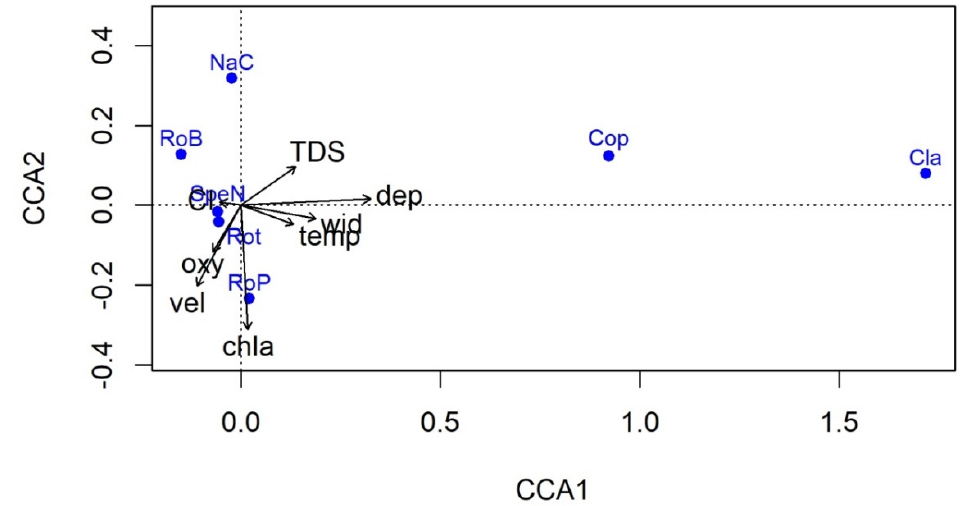
Figure 6. Zooplankton taxa abundance and species number of total zooplankton among environmental factors in the Bukówka stream. Canonical correspondence analysis (CCA) constrained ordination of taxa from sites with different environmental conditions. Environmental variables: